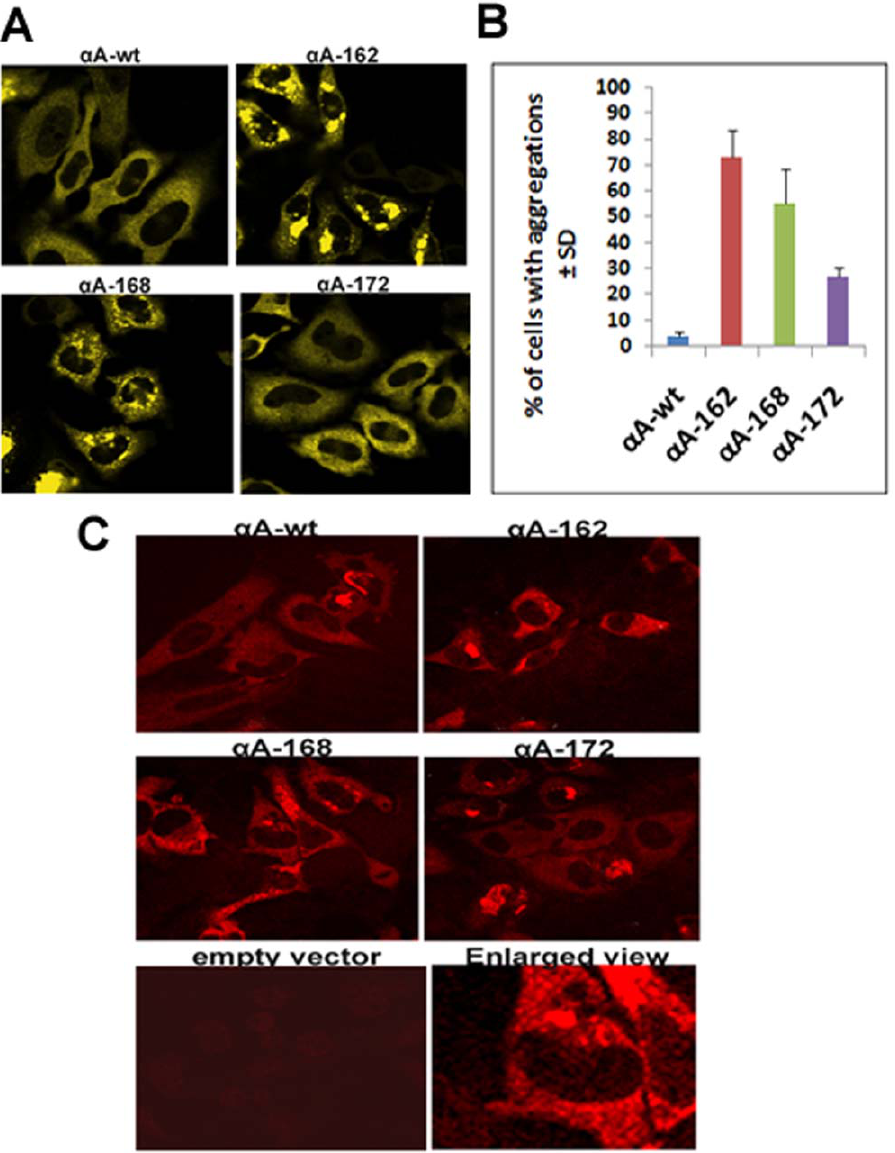
Figure 1. Indidivudal expression of YFP-tagged a A-Crystallin wild-type and truncated constructs in HeLa cells. A: LSM confocal images of HeLa cells expressing a A-wt and truncated constructs showing intracellular aggregates . Cells expressing withYFP a A162 and YFP a A-168 showing aggregates but not in a A-wt and a A172 transfected cells. YFP was excited at 514 nm and the images were collected by BP 530–600 nm filter. B: Bar diagram illustrating % of cells containing aggregation (as illustrated in Fig. 1A) . Randomly selected fields of 50 cells were counted and % of cells containing aggregation was calculated for each group. The values of all the truncated constructs are statistically significant at p , 0.05 (t-test) compared to the a Awt group. C: Immunofluorescence analysis of a A-crystallin over expression in HeLa cells . a A-crystallin is abundantly localized in the cytoplasm, however, nuclear localization as in the form of foci were seen in a Awt, a A162 and a A168 individually expressing cells. In cells transfected with empty vector, there was no staining indicates that there was no endogenous expression of a A-crystallin. Cells containing aggregates were stained intensely in a A162 and a A168 expressing cells. An enlarged view from a A168 expressing cells shows nuclear foci (bottom right panel) and stained cytoplasmic aggregates. The images are representative of four similar images obtained in three independent experiments.